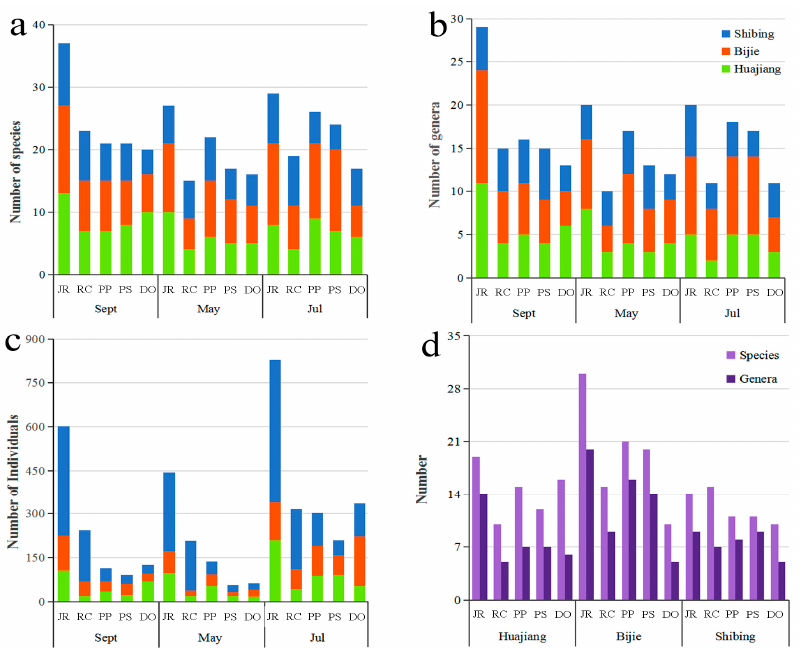
Figure 6. Number of species, individuals, and genera of typhlocybine leafhoppers in different study areas and host plants (( a ): Number of species in different host plants; ( b ): Number of genera in different host plants; ( c ): Number of individuals in different host plants; ( d ): Number of species and genera of typhlocybine leafhoppers in different study areas; (JR): Juglans regia , (RC): Rhus chinensis